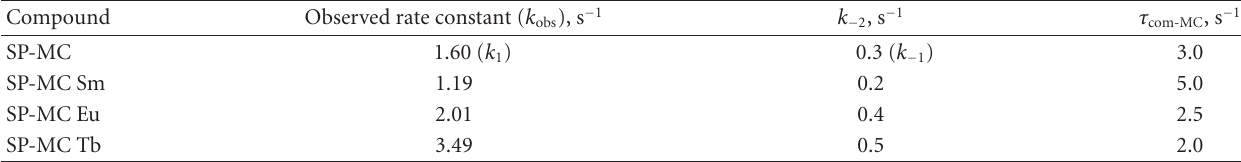
Table 3: Observed rate constant and relaxation times of MC and its complexes in acetonitrile at 25 ◦ C. Compound